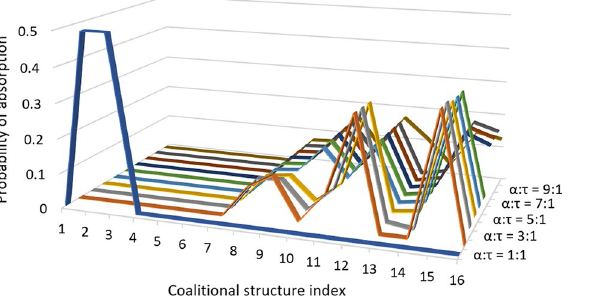
Fig. 6 Probability of absorption of each coalitional structure for weight coefficient α = 1,2, ... ,10 and τ =